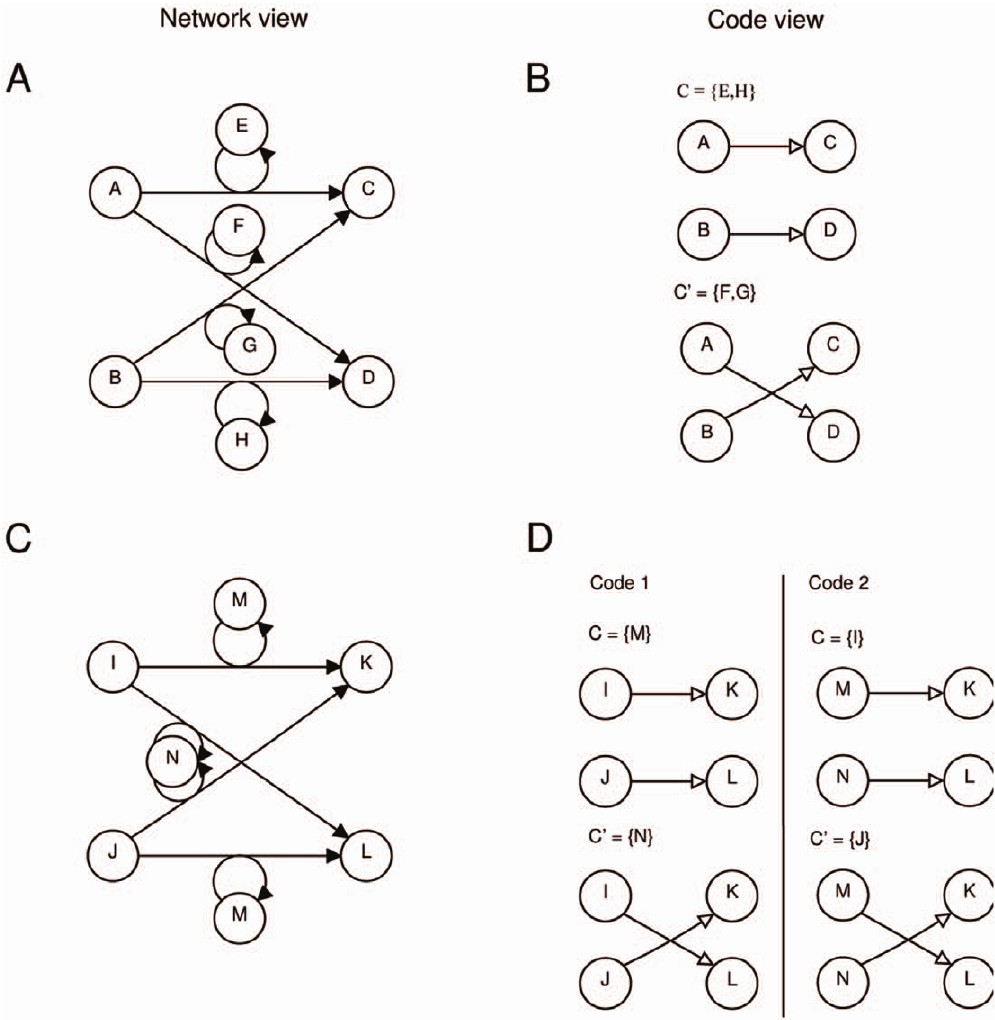
Figure 1. Two exemplary reaction networks containing molecular codes. Panel A: Chemical reaction network S M , R T with species M ~ f A , B , C , D , E , F , G , H g and reaction rules R ~ f A z E ? C z E , A z F ? F z D , B z G ? G z C , B z H ? H z D g ; panel B: Code pair that can be realized by the network in panel A. The binary molecular codes are characterized by S ~ f A , B g , M ~ f C , D g , and the two molecular contexts C ~ f E , H g , and C ’ ~ f F , G g ; panel C: Chemical reaction network with species M ~ f I , J , K , L , M , N g and the reactions R ~ f I z M ? K z M , I z N ? N z L , J z M ? M z L , J z N ? N z K g ; panel D: Two molecular code pairs can be realized by the network in panel C. Note that our code analysis does not depend on catalysis. Replacing a reaction like A z E ? C z E by A z E ? C would lead to the same molecular codes.